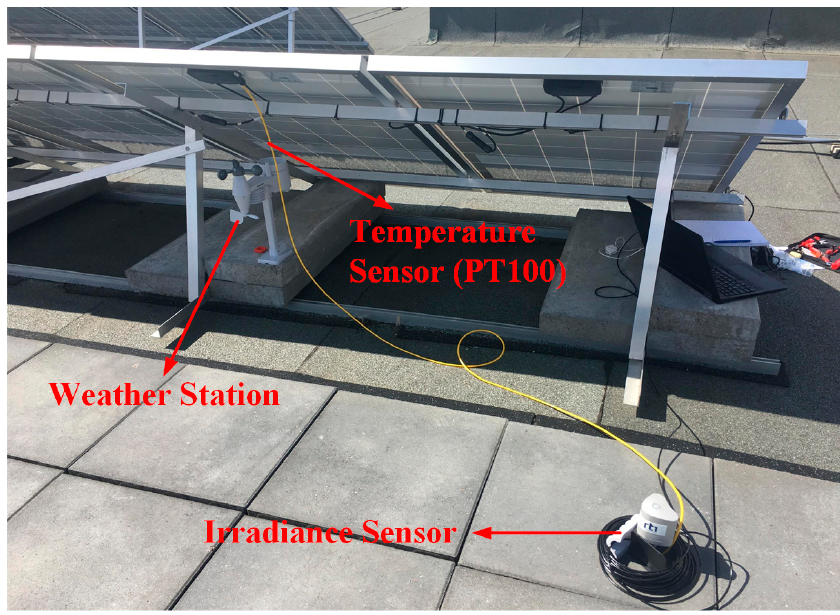
Figure 8. Testing platform for thermal model.